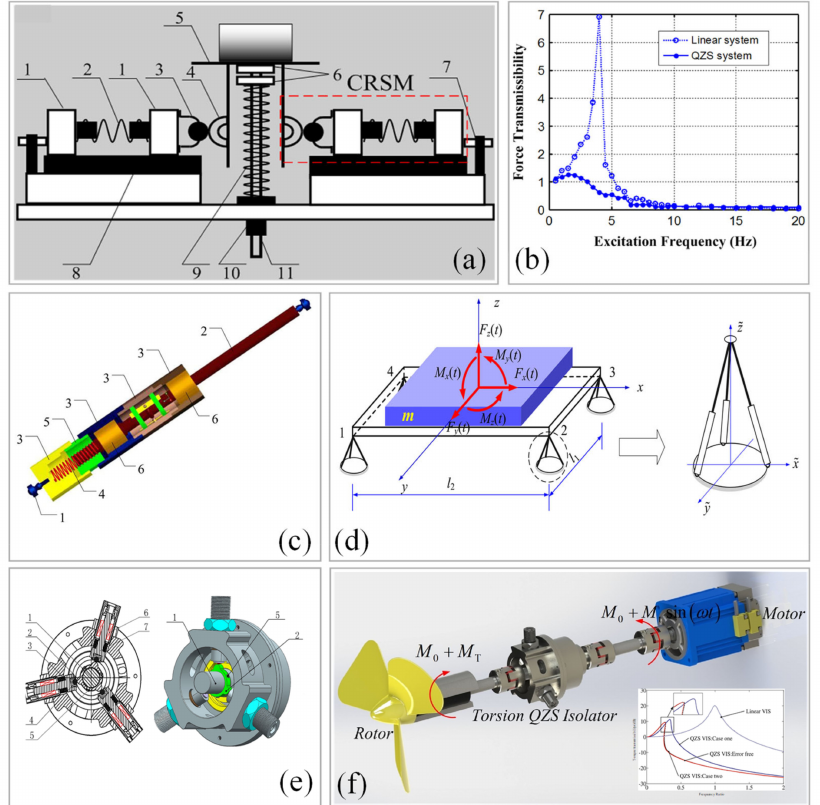
Figure 15. The cam-roller-spring QZS vibration isolator proposed by Zhou et al. [44–47]: ( a ) Single- degree-of-freedom (SDOF) vibration isolator [44]; 1-slider, 2-horizontal spring, 3-roller, 4-semi-circular cam, 5-loading support, 6-vertical adjuster, 7-horizontal adjuster, 8-sliding rail, 9-vertical spring, 10-linear bearing, and 11-sliding rod; ( b ) Force-displacement characteristic curve; ( c ) Schematic diagram of the QZS strut [45]; 1-ball joint, 2-rod, 3-sleeve, 4-coil spring, 5-adjuster, 6-linear bearings; ( d ) 6-DOF vibration isolation platform; ( e ) Torsional vibration isolator with QZS [46,47]; 1-left shaft connector, 2-cam, 3-disk spring stack, 4-universal wheel, 5-fastening screw, 6-linear bearing, 7-sliding rod; ( f ) Application in a shaft system. Figures adapted with permission from Refs. [44–46]. Copyright 2015/2017/2017, copyright Zhou,